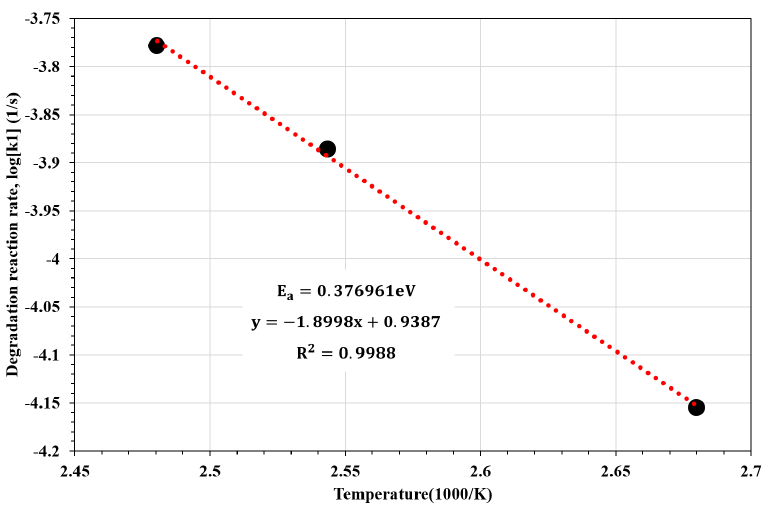
Figure 7. Kinetic constants in the LID process obtained from a kinetic simulation using a cyclic reaction model, and the activation energy calculated by linear